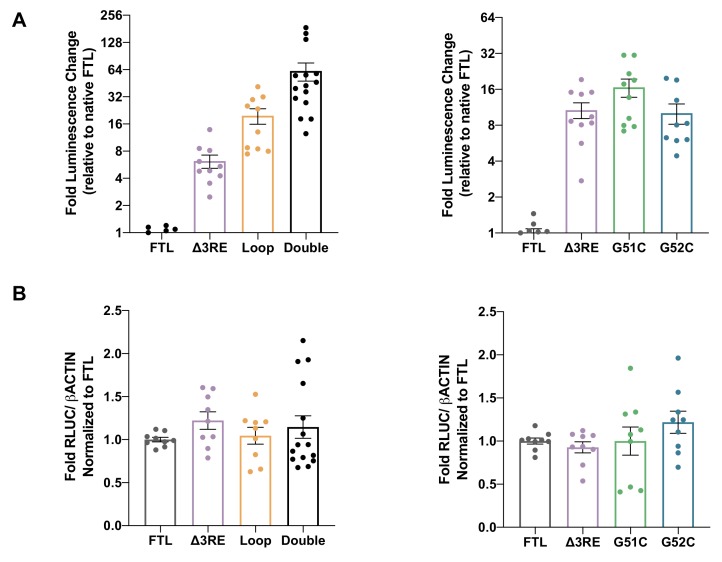
Luciferase readouts and mRNA stability during 6 hr mRNA transfections.(A) Luciferase activity of HepG2 cells transfected with mRNAs encoding the WT FTL 5ʹ-UTR or various mutant mRNAs. The first graph shows experiments with the ∆3RE, Loop (A15G/G16C), and Double mutants, while the second graph shows experiments with the hyperferritinemia mutations (G51C and G52C), normalized to WT FTL reporter luciferase luminescence. The results are from nine biological replicates with error bars representing the standard error of the mean. (B) RNA extraction and RT-qPCR of cells harvested at 6 hr post-transfection with the various luciferase reporters. The ACTB mRNA was used as a control to normalize across samples. Error bars represent the standard error of the mean for three biological replicates, with three technical replicates each.10.7554/eLife.48193.009Figure 2—figure supplement 2—source data 1.Luciferase reporter and qPCR readouts relative to nativeFTL.